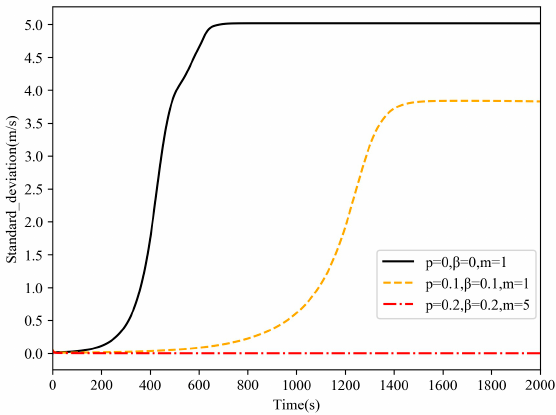
Figure 4. Standard deviation values of velocity distributions simulated by various parameter values: